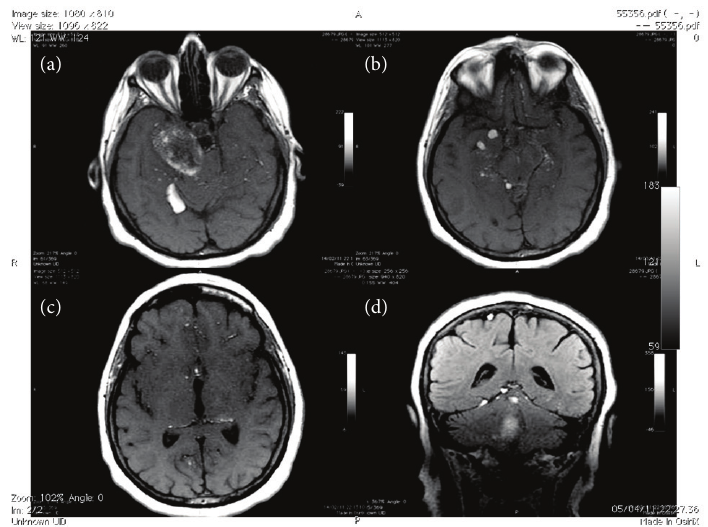
F 3: Axial SE T1-w images showed multiple bilateral micro- and macrolipid accumulations (fatty droplets ) into cerebral cisternal and cortical spaces ((a), (b), and (c)); coronal FLAIR showed hyperintense macrocollected interposed between occipital lobe and cerebellum and at the level of cerebral convexity